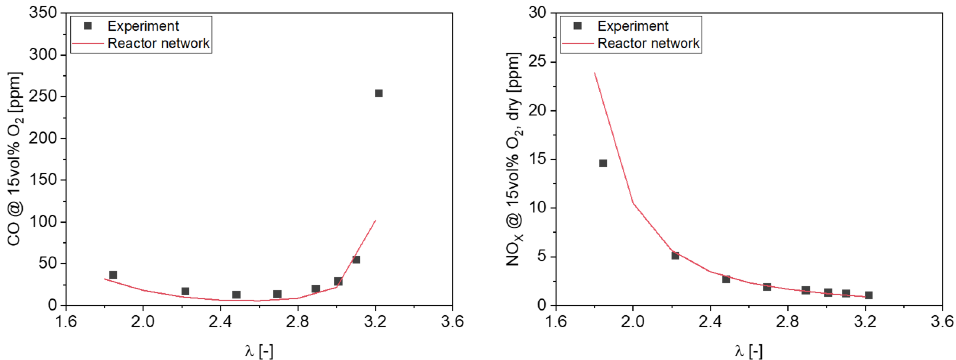
Figure 4. Validation of the reactor network with experimental data from a FLOX based natural gas combustor [20] at 69% of maximum thermal